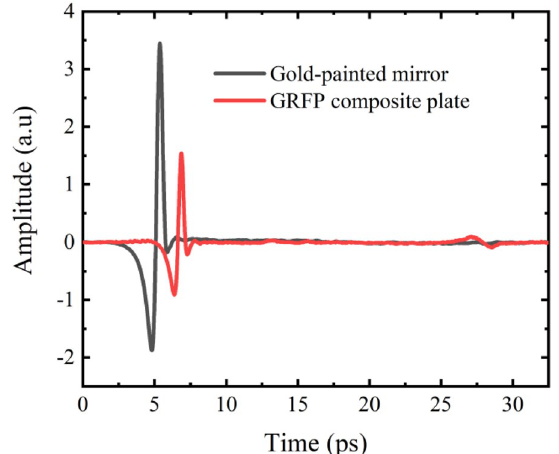
Figure 9 Comparison of pulsed THz waves reflected from the gold-painted mirror and the GFRP composite